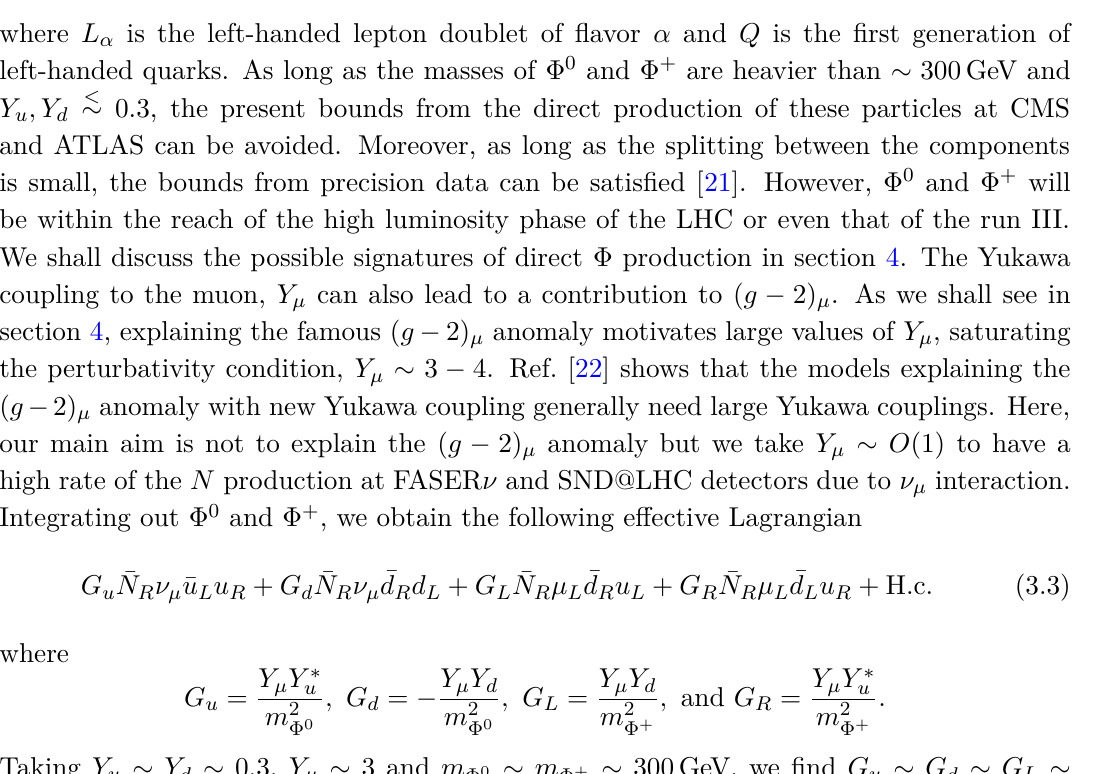
= G = 10 − 5 GeV − 2 u d